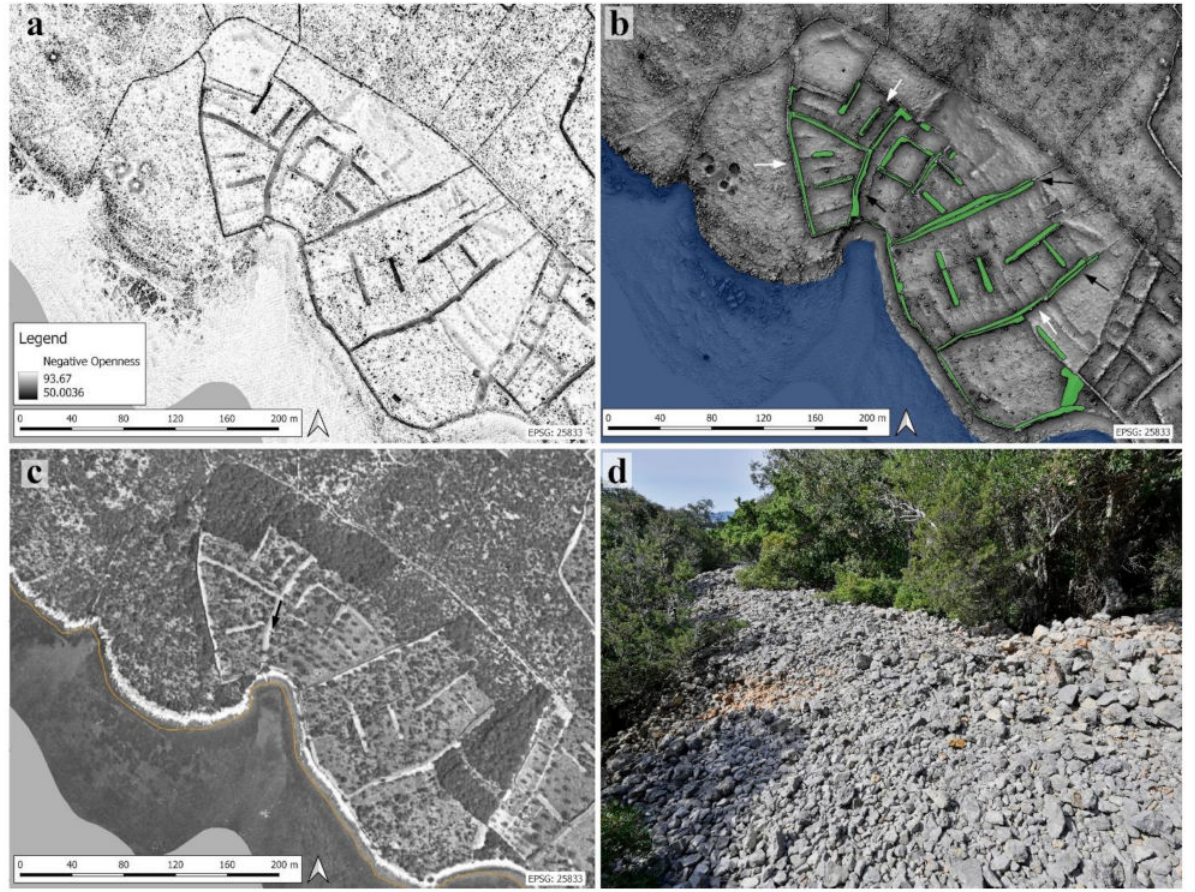
Figure 15. ( a ) The massive stone clearance deposits have a clear signature in the Negative Openness (r = 10) from the DFM filtered with “stone_wall” setting. ( b ) Interpretation map of massive stone deposits. White arrows point to deposits heaped up against double dry stone walls; black arrows, where deposits might overlie earlier double dry stone walls (Visualization: cVAT). ( c ) 1953 Digital Orthophoto Map (source: State Geodetic Administration Geoportal/Geoportal Državne geodetske uprave—geoportal.dgu.hr). The massive stone deposits are clearly visible. The area occupied by the deposits is characterized by horticulture. ( d ) On-site photograph of stone deposit. The black arrow on ( c ) shows the position and viewing direction (Photo: M. Doneus, 13 April